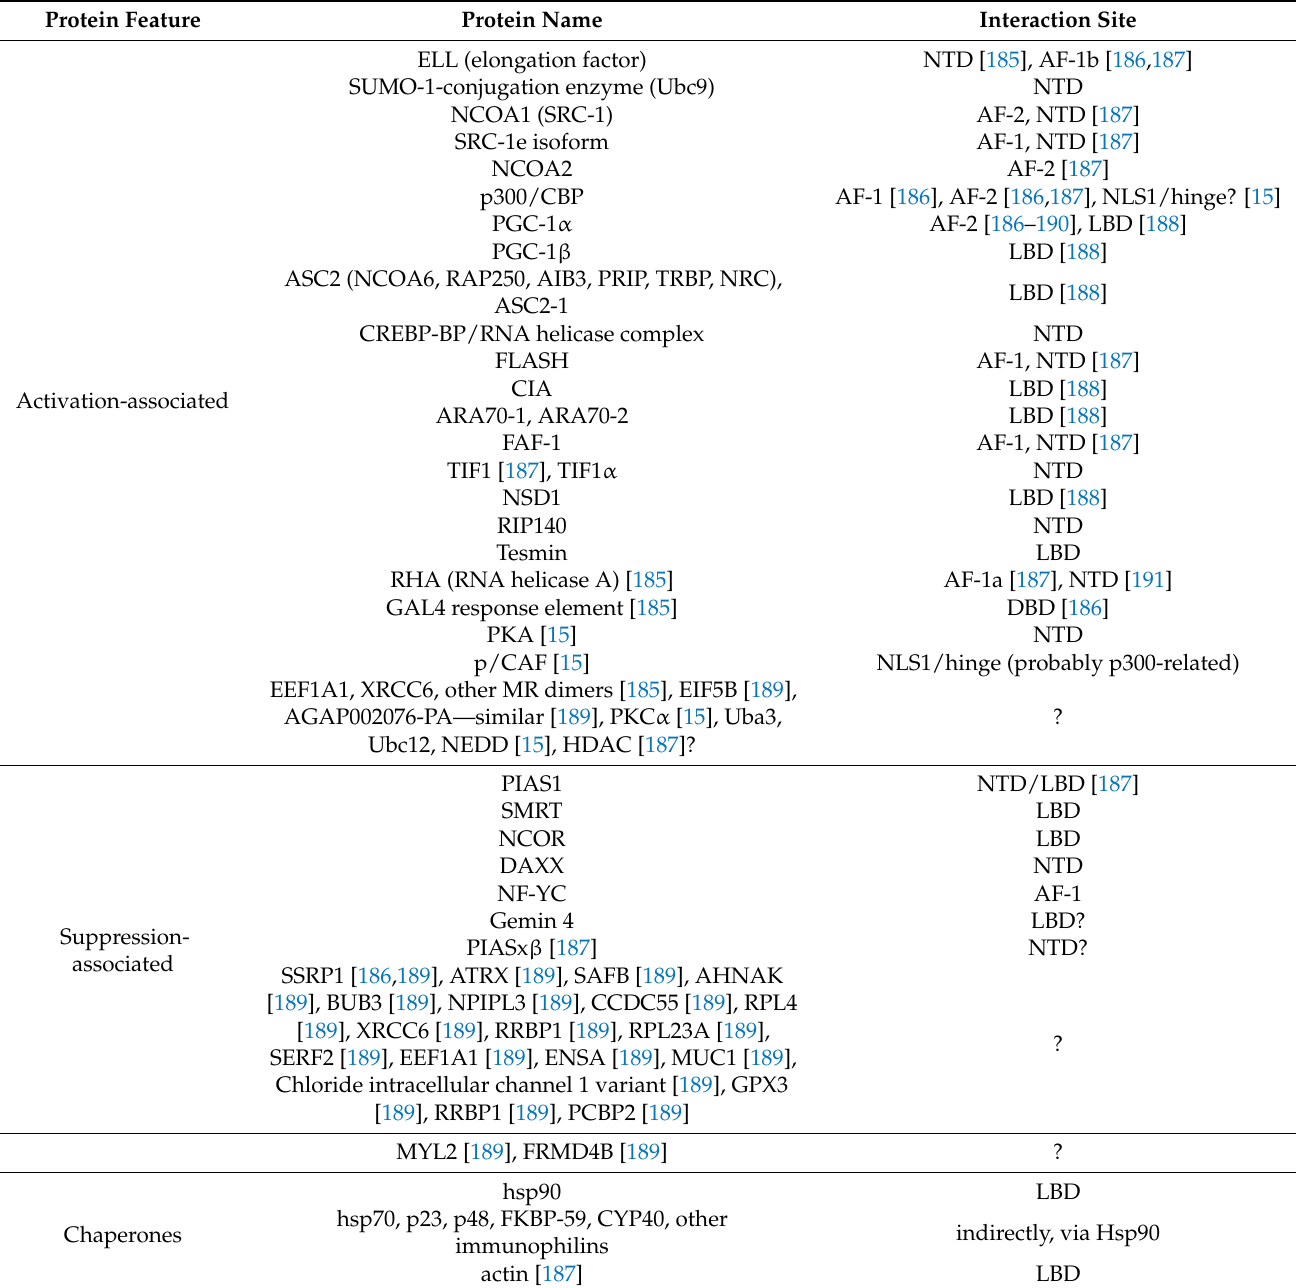
Table 5. Interactome of MR (citation: if not